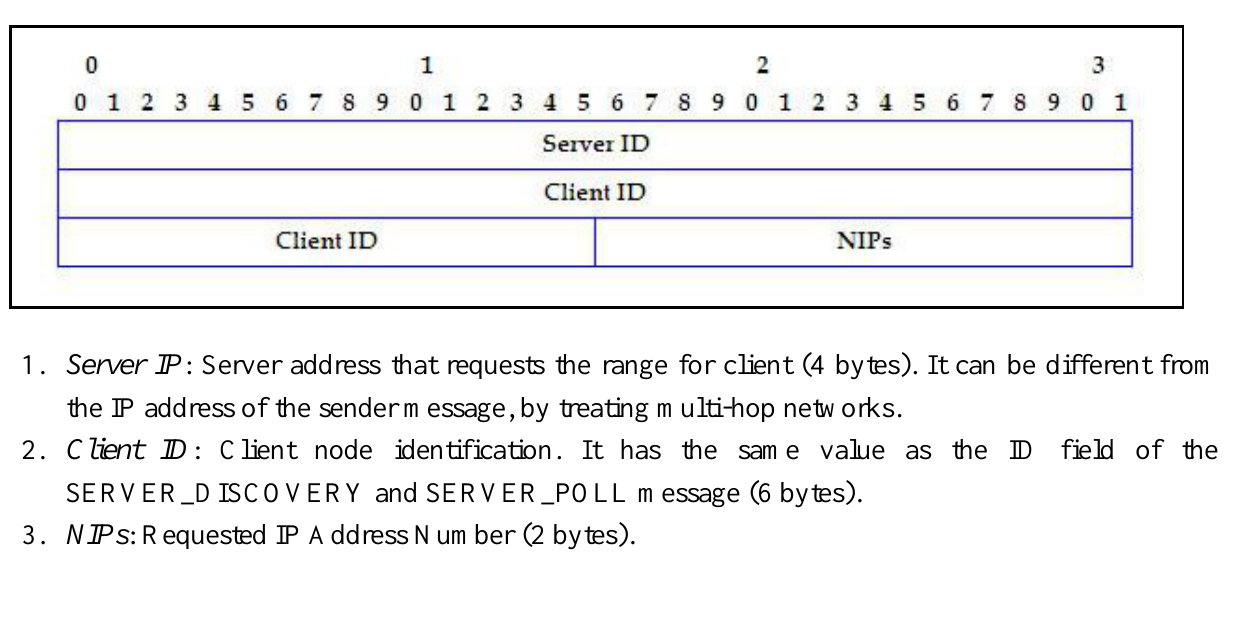
Figure 7. IP_RANGE_REQUEST message